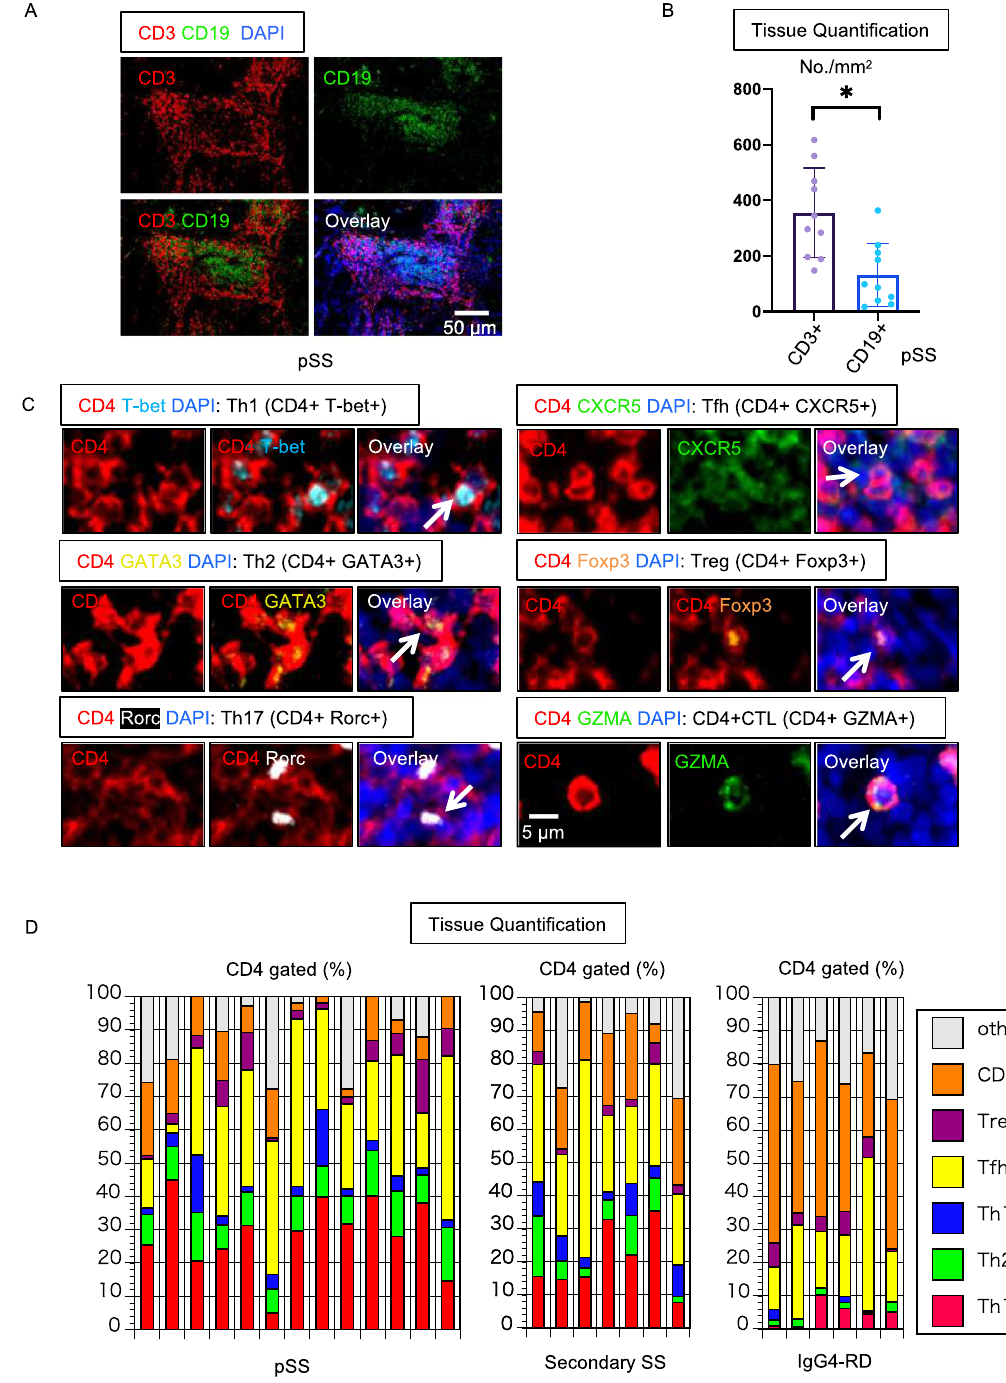
Figure 1. The most prominent CD4 + T cell subsets in SS tissues are Th1 cells and Tfh cells. ( a ) Representative multi-color immunofluorescence image of CD3 (red), CD19 (green) and DAPI (blue) staining in a pSS lesion (patient number 2). ( b ) Absolute numbers of CD3 + T cells, CD19 + B cells in pSS (n = 10). Paired t test used to calculate p-value. ( c ) Representative multi-color staining showing each CD4 + T cell subset. [Th1: CD4+ (red) T-bet+ (light blue)] [Th2: CD4+ (red) GATA3+ (yellow)] [Th17: CD4+ (red) RORγ+ (white)] [Tfh: CD4+ (red) CXCR5+ (green)] [Treg: CD4+ (red) Foxp3+ (orange)] [CD4+ CTLs: CD4+ (red) GZMA+ (green)] (d) Relative proportions of Th1, Th2, Th17, Tfh, Treg and CD4+ CTL subsets in tissues from pSS (n = 13), secondary SS (n = 7) and IgG4-RD patients (n = 6). Error bars represent mean ± SEM. *p <